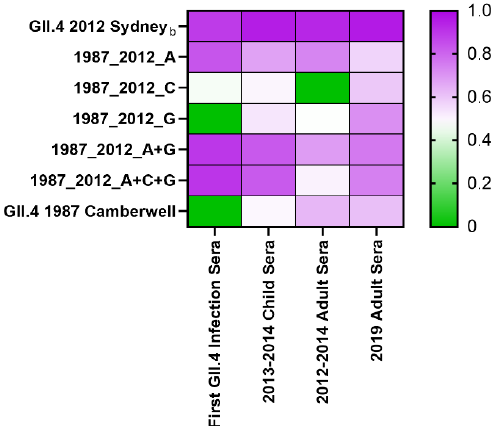
Figure 5. Repeat GII.4 Sydney exposure correlates with antigenic site G nAb titer. nAb titers to GII.4 2012 Sydney and antigenic site-specific responses were compared by Spearman correlational analysis, and the r value was determined. Pairs with insignificant correlation were assigned r = 0. A related GII.4 Sydney strain (GII.4 2012 Sydney b ) was included in the analyses for comparison.